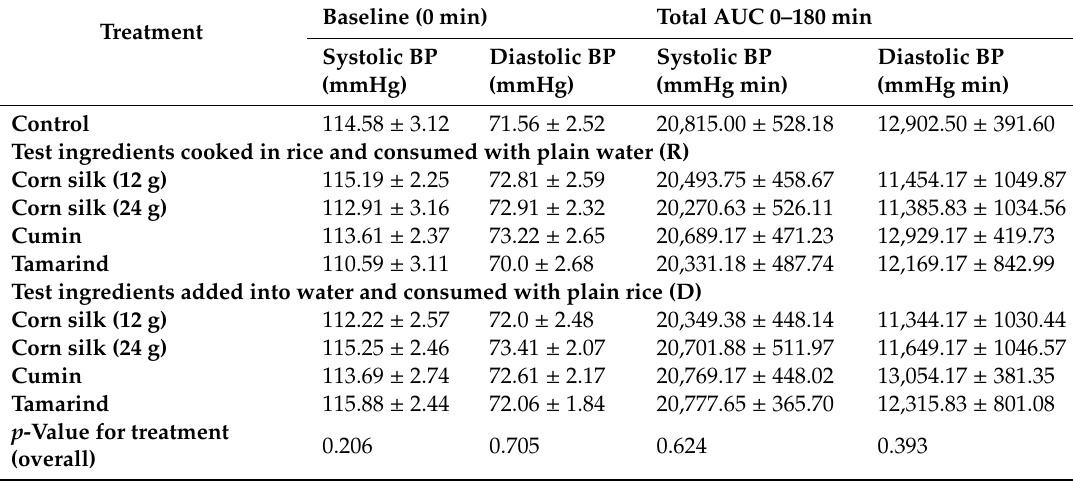
Table 4. Baseline and total areas under the curve (tAUCs) of blood pressure over the postprandial period.